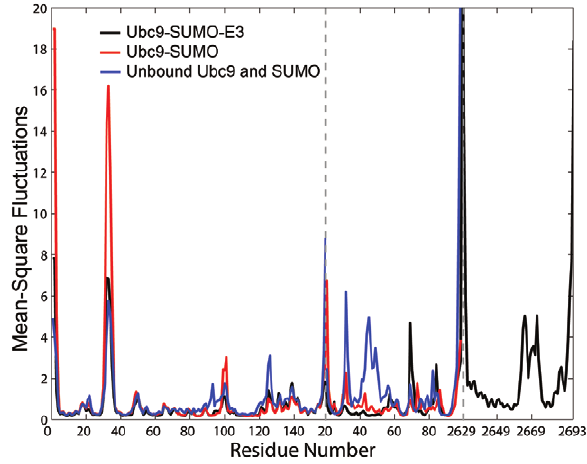
Figure 5. Mean square fluctuations from unbound Ubc9 (blue), unbound SUMO (blue), Ubc9-SUMO complex (red) and Ubc9- SUMO-RanBP2 complex (black) simulations. The x-axis gives the residues numbers for each chain, where the dashed lines on the figure mark the separations between chains. Although coded in the same color, the results for unbound Ubc9 and unbound SUMO are from separate simulations, details of which are given in Methods and Text S1.